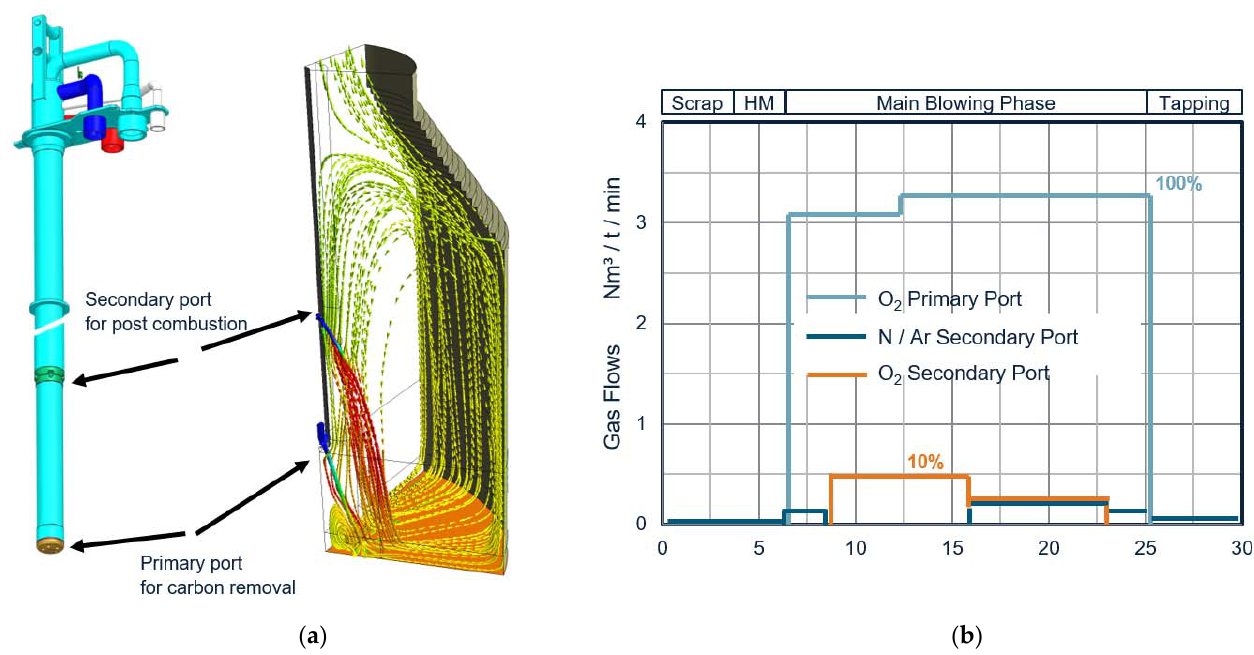
Figure 9. ( a ) DFPC lance and CFD simulation for optimized heat transfer depending on BOF geom ‐ etry ( b ) blowing pattern and specific flow rates for application of DFPC lance. ( b ) blowing pattern and specific flow rates for application of DFPC